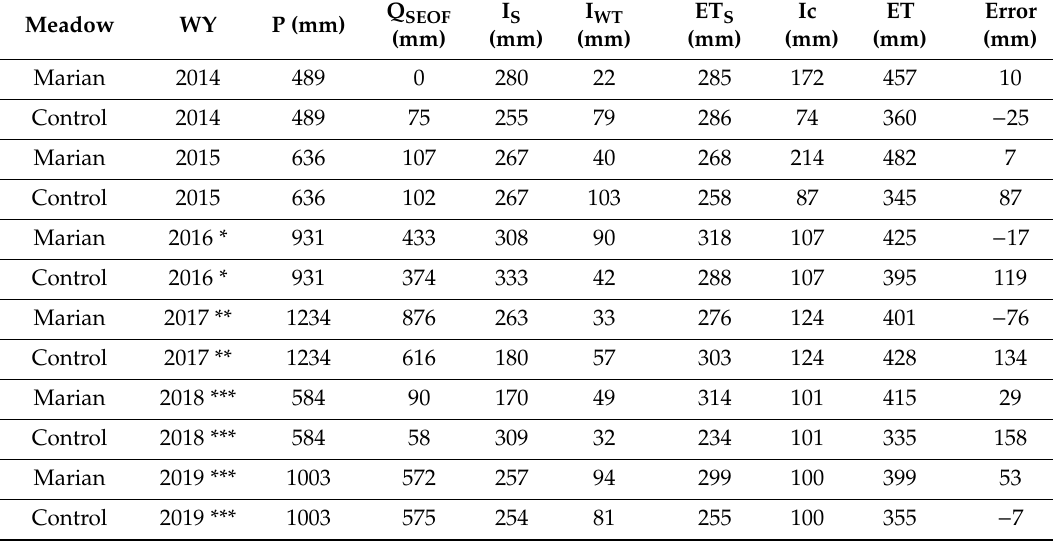
Table 7. Water budget for pre-restoration 2014–2015 water years (WY) and water years 2016–2019 after restoration by encroached conifer removal and upslope forest